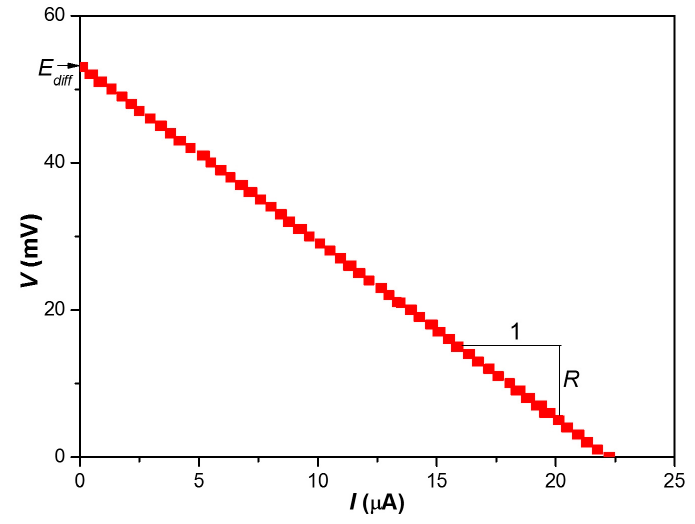
Figure 6. Typical voltage–current curve of the anisotropic nanoporous anodic aluminum oxide